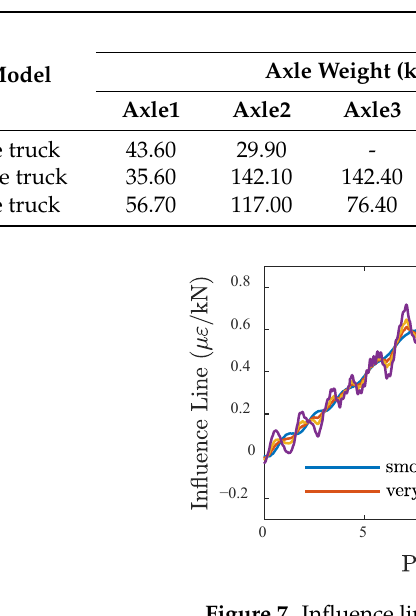
Figure 7. Influence line under different RSCs.